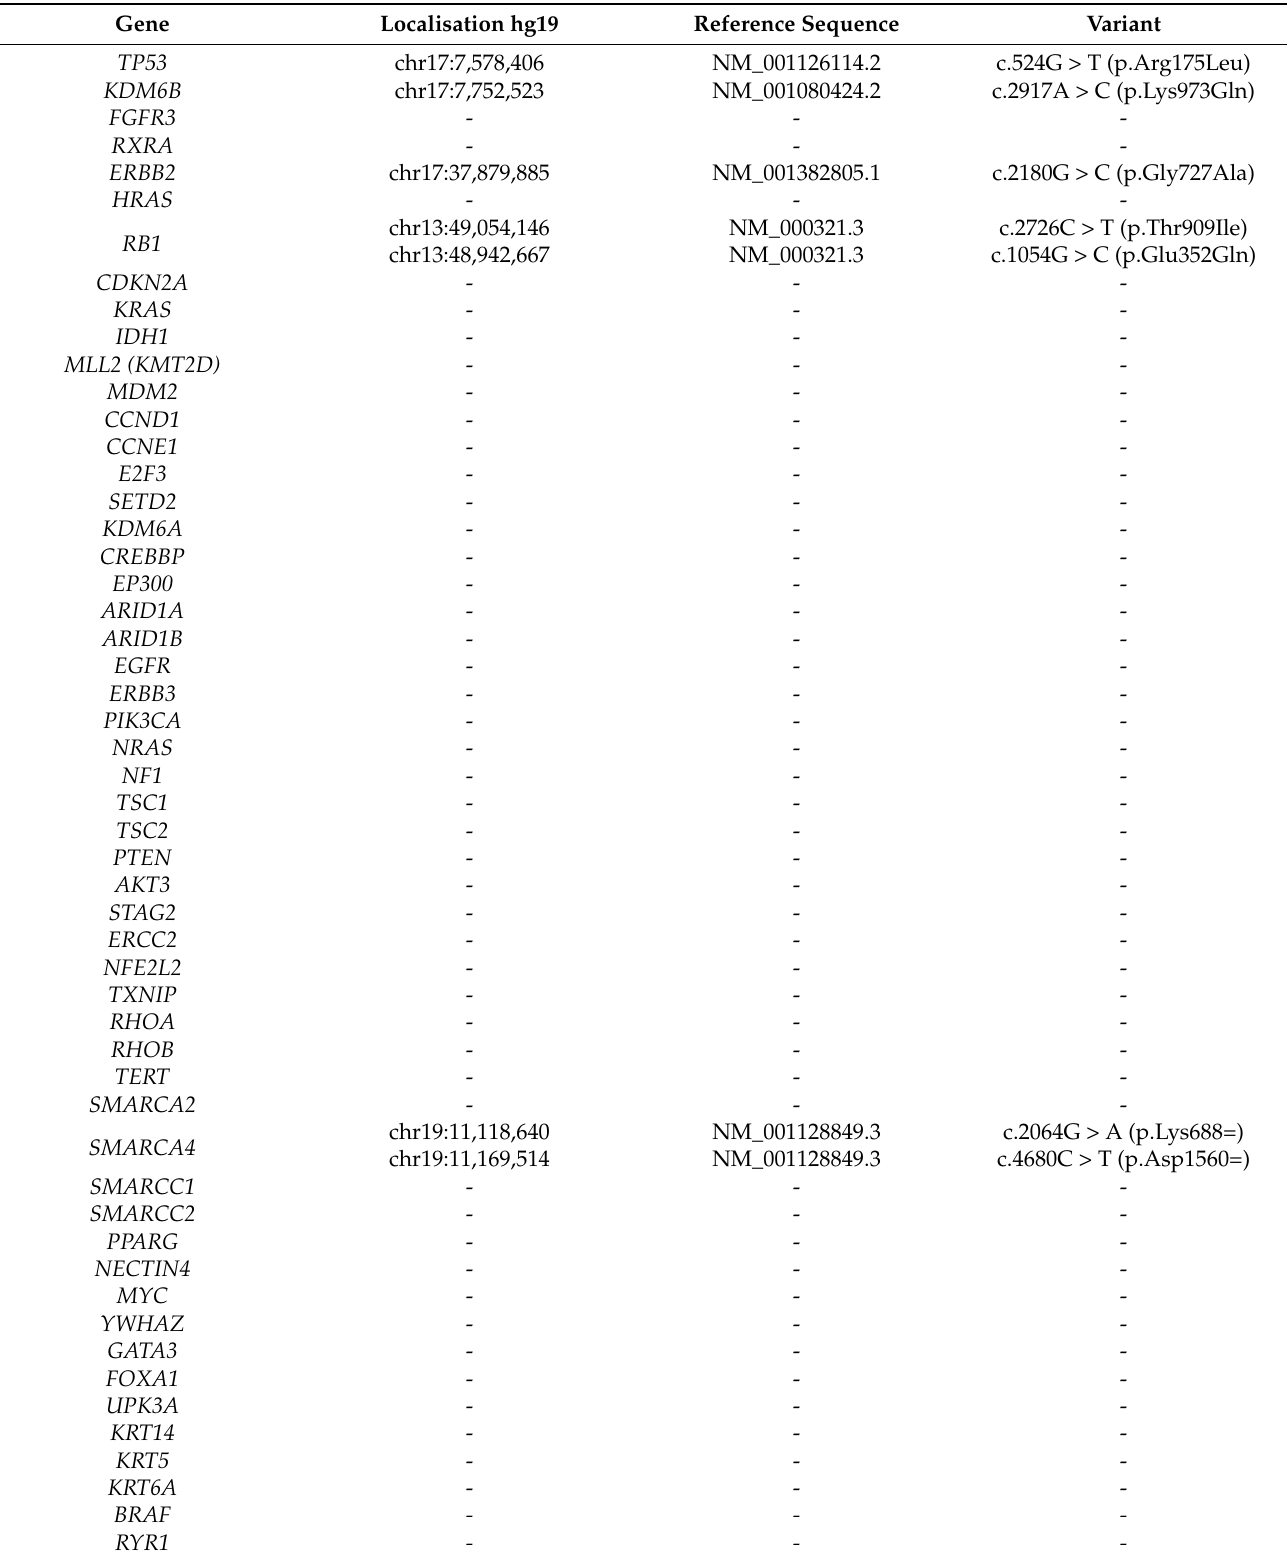
Table A1. A complete list of manually analysed